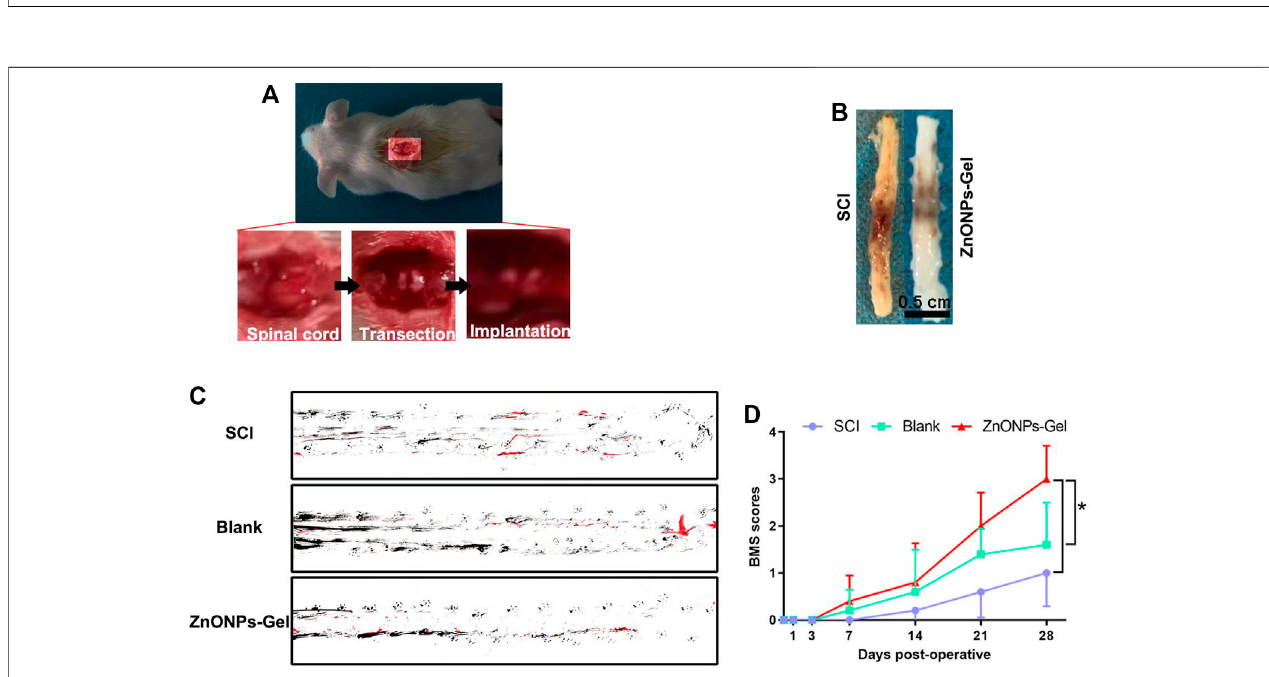
FIGURE 2 | ZnONPs-Gel recovered motor function on days 28 after SCI. Model of injured spinal cord (A) . Representative images of the injured spinal cord in SCI and ZnONPs-Gel groups (B) .Representativeimagesoffootprint analysisintheSCI,blank,and ZnONPs-Gel groups (C) .Representativequanti fi cationofBMSscoresin SCI, blank, and ZnONPs-Gel groups (D) . Data are mean ± SD ( n (cid:2) 3).